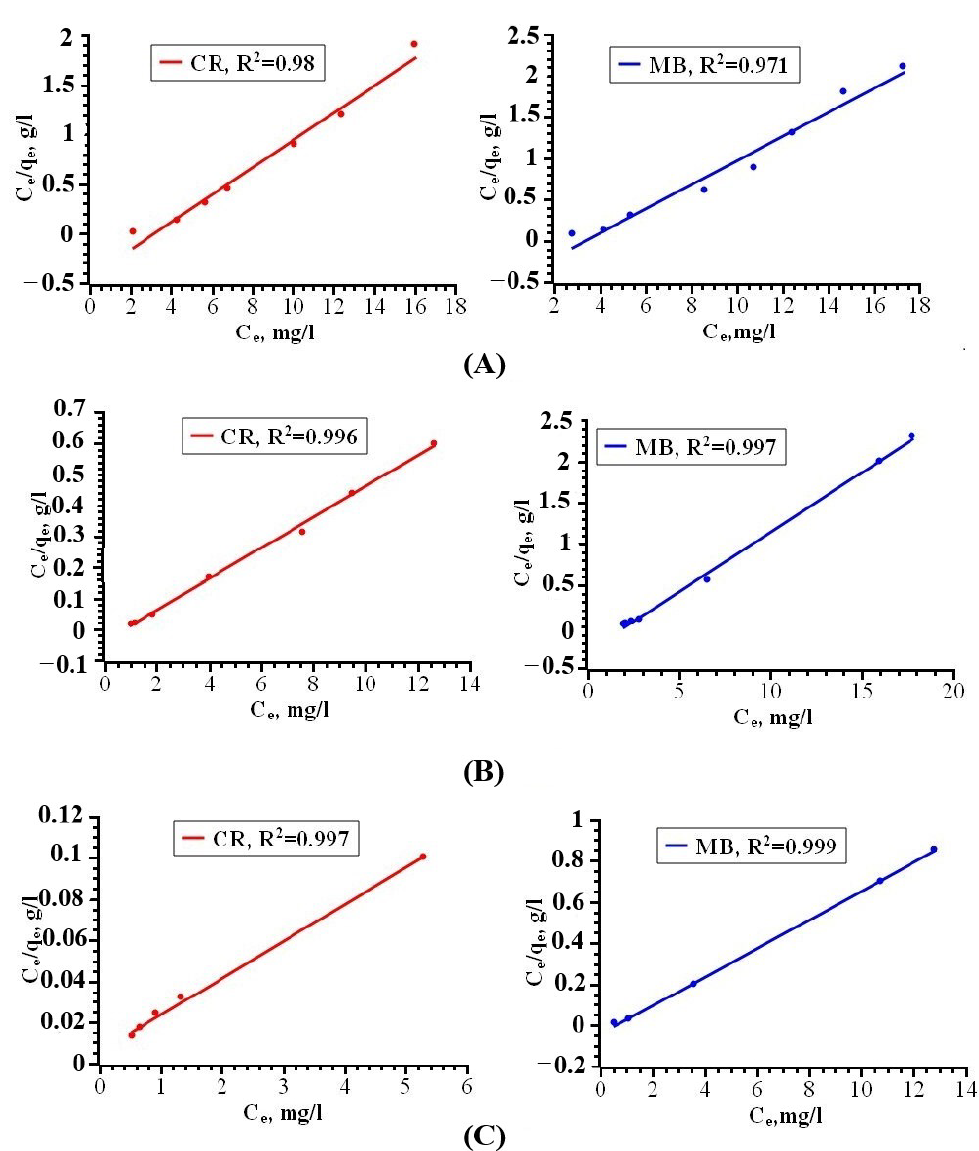
Figure 11. Langmuir isotherms of CR and MV at 283 ( A ), 291 ( B ), and 308 K ( C ).